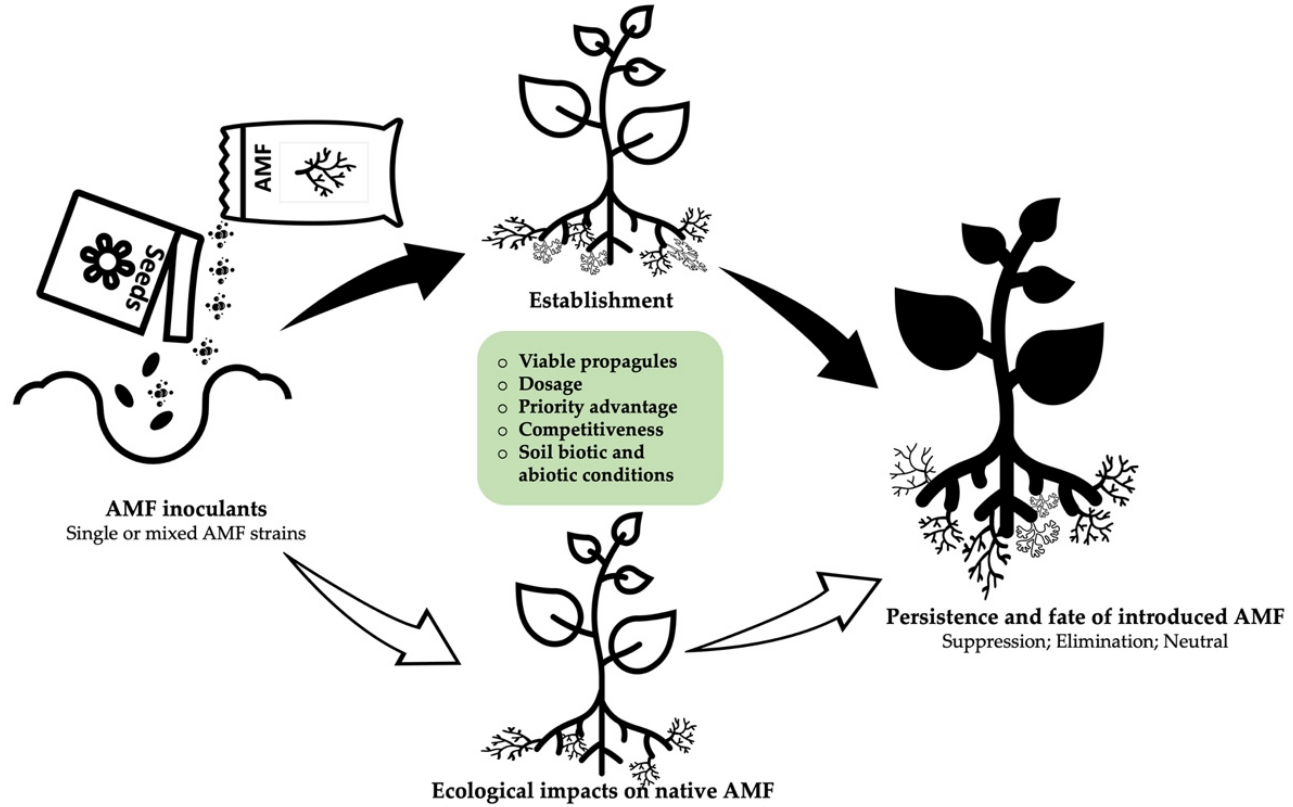
Figure 3. Overview of ecological impacts of AMF inoculants and driving factors.